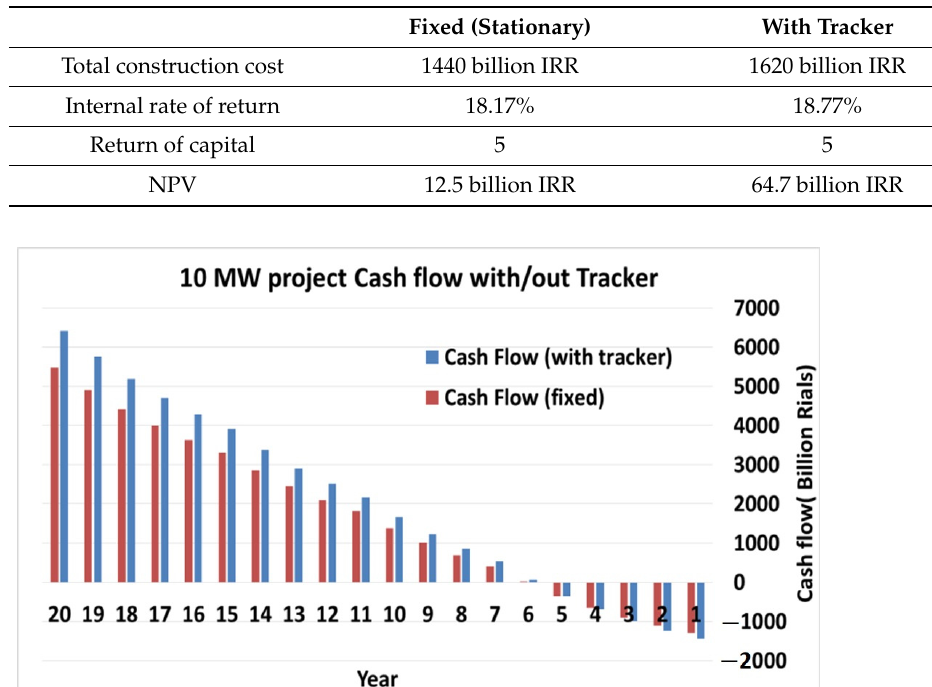
Figure 19. Comparing the financial flow of building two 10 MW power plants in Qom, assuming the use or non-use of a tracker in the case of a decrease in the US$ to IRR exchange